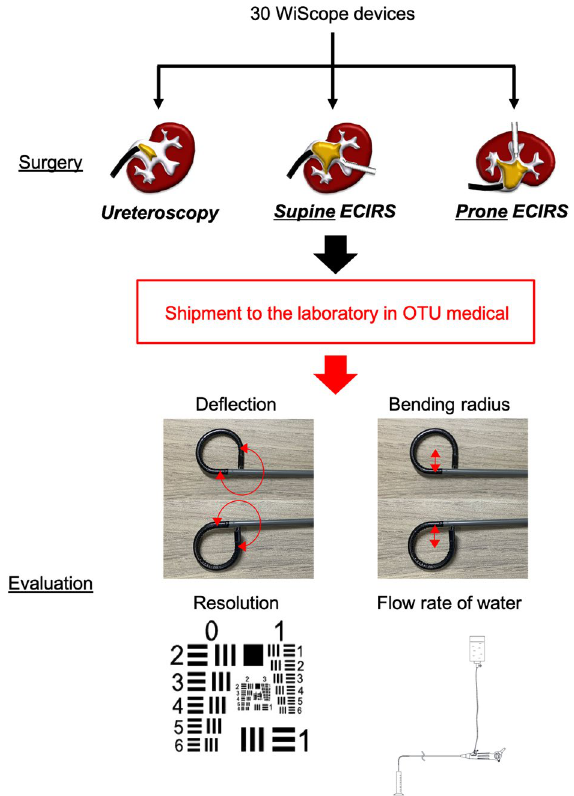
Figure 1. Study design. This prospective ex vivo study analyzed the performance of 30 WiScope devices (OTU Medical, San Jose, CA, USA) immediately after their use. We included scopes used for ureteroscopy and ECIRS in the prone and supine positions, ten each. All scopes were sent after a single surgical use to OTU Medical for testing and damage